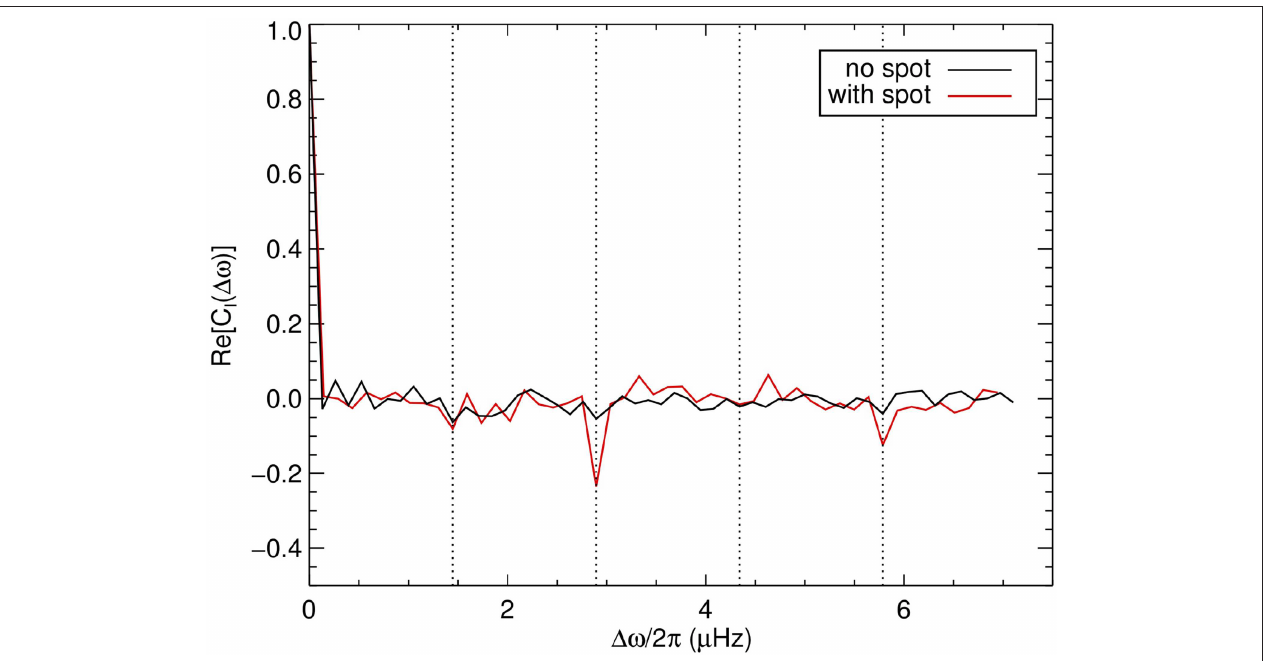
FIGURE 12 | Autocorrelation of the intensity power spectrum as defined by Equation (73) for a starspot with ǫ = 0.1 (red curve). A stellar rotation period 2 π/(cid:127) β = 8 days, an inclination angle i = 80 ◦ , and a starspot colatitude β = 80 ◦ were chosen for the post processing. Vertical dotted lines denote frequency separations 1ω = j (cid:127) β where j = 1,2,3,4. For comparison, the black curve is the case with no